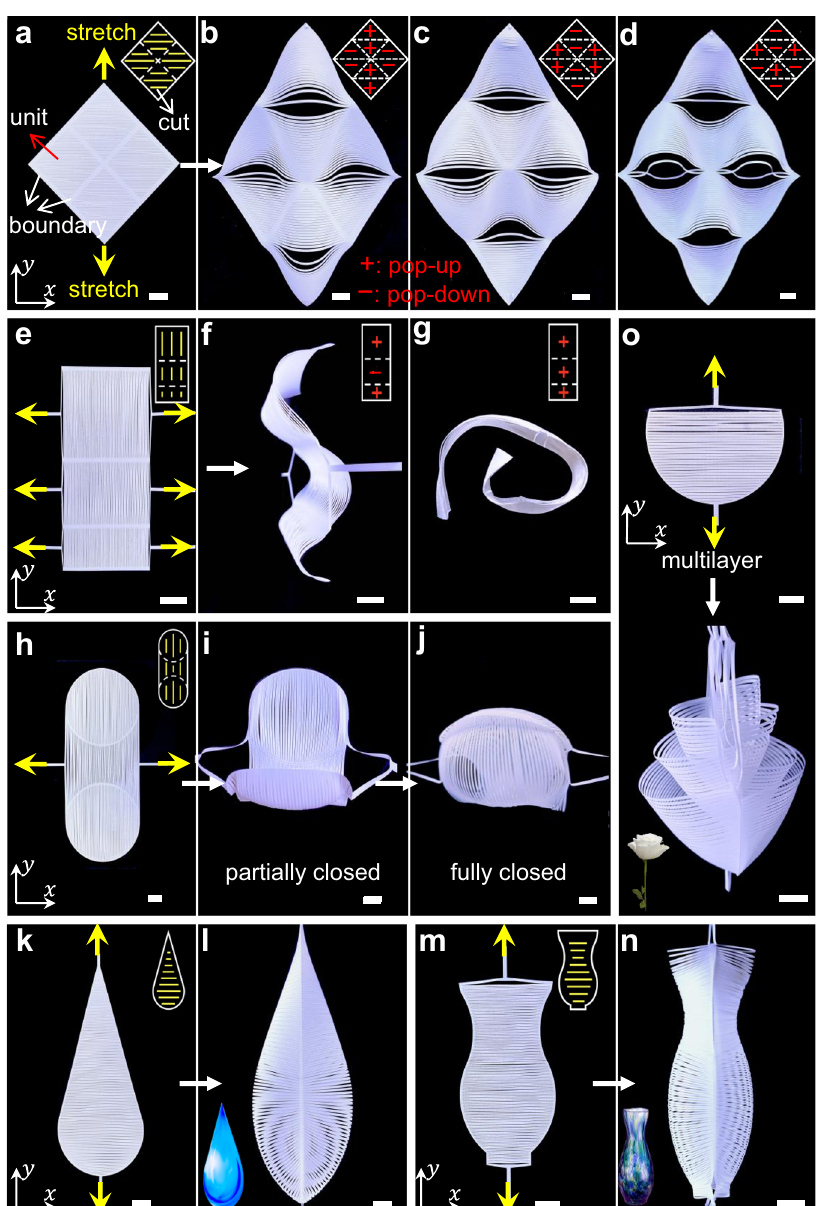
Fig. 4 Combinatorial designs of 2D kirigami precursors for complex 3D shapes under uniaxial tension. a – j Recon fi gurable 3D shapes through bistability of discrete ribbons. a 2D precursor composed of 2 × 2 square units with zero boundary curvature. b – d Uni-axial stretching induced recon fi gurable human face-like morphologies with switchable smiley ( b ) and sad ( c ) expressions, as well as eyeglasses ( d ) by tuning the popping directions of ribbons (insets). e 2D precursor composed of 3 × 1 rectangle units with zero boundary curvature. f , g Formation of switchable sinusoidal wavy and coiled shapes. h 2D precursor composed of an array of two circular units bridged with a biconcave unit. i , j Formation of a 3D encapsulated Venus fl ytrap-like shape through uniaxial stretching. k – n Formation of a 3D droplet-like shape ( l ) and vase-like shape ( n ) by uni-axially stretching 2D precursors with different combined boundary curvatures ( k , m ). Insets show the image of a droplet and a vase. o Formation of a fl ower-like shape by uni-axially stretching multiple layers of semi-circular 2D precursors. Scale bars = 10